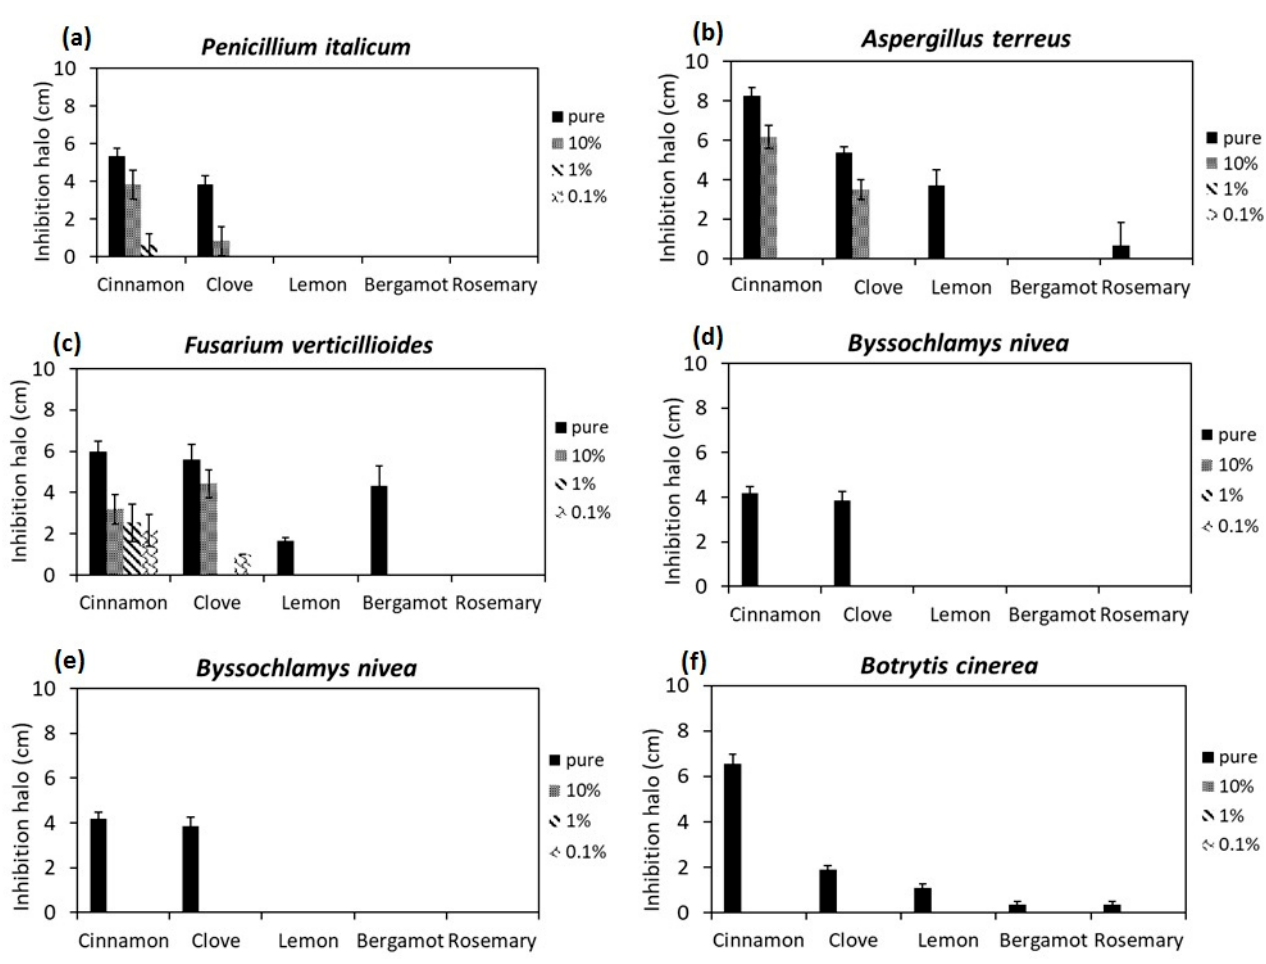
Figure 2. Antifungal activity evaluation of EOs with disc diffusion technique. Measurement of inhibition halo diameters (cm) created around the discs; ( a ) Penicillium italicum ; ( b ) Aspergillus terreus ; ( c ) Fusarium verticillioides ; ( d ) Byssochlamys nivea ; ( e ) Rhizopus nigricans ; and ( f ) Botrytis cinerea . 10%, 1% and 0.1% indicate concentrations of EOs ( v / v ).